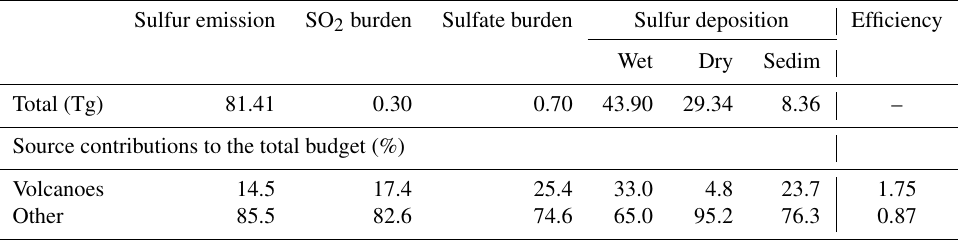
Table 5. The 2013 annual global mean SO 2 emissions, sulfur budget and deposition quantities (in teragrams). The contribution of sulfur species due to volcanic emissions or other emission sources are presented (in percent). The efficiency is the ratio between the contribution of the sulfate burden and the contribution of the total sulfur emission attributed to a specific source. In other words, it is the fractional contribution from anthropogenic and volcanic sources to the sulfate burden. Note: sedim –